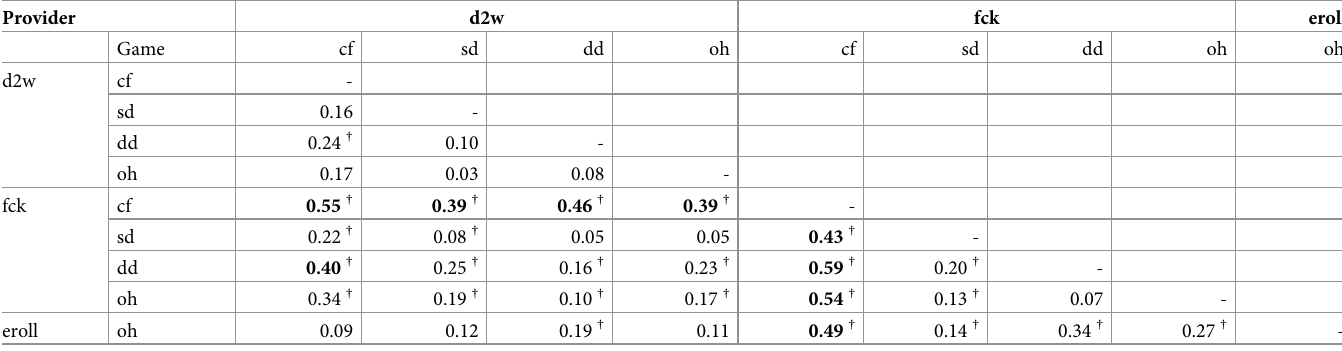
† denotes a significant result ( p < 0.01) and coefficients greater than 0.35 are highlighted. Key: d2w = Dice2.Win, fck = FCK.com, eroll = Etheroll.com, cf = coin